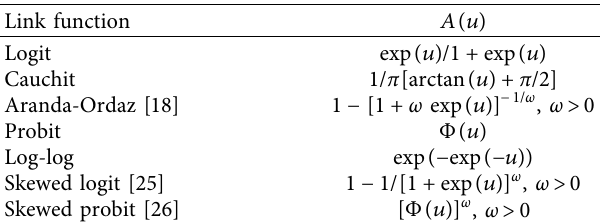
Table 1: Diferent link